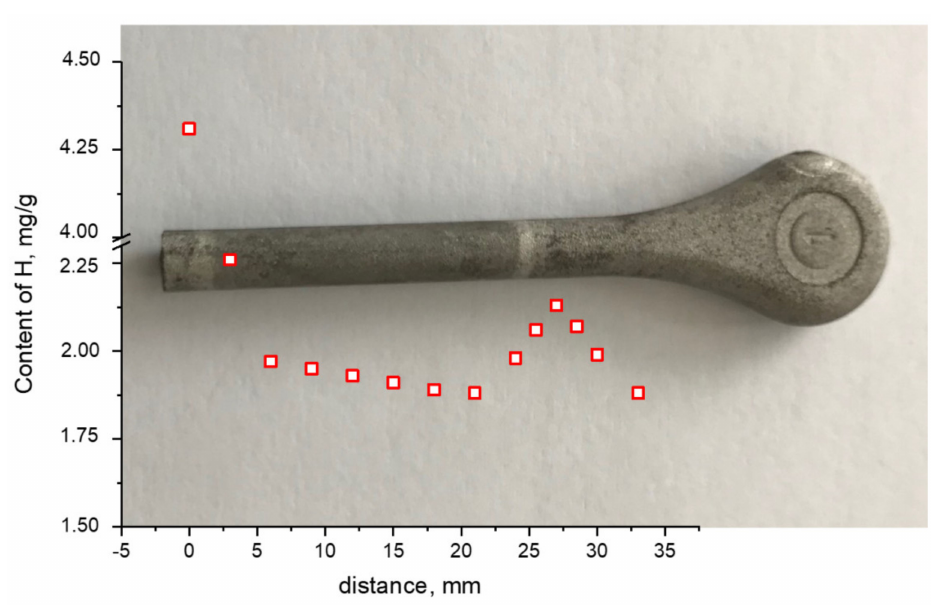
Figure 9. Concentration of absorbed H along the length of Ti64 dog-bone sample after degradation of Mg